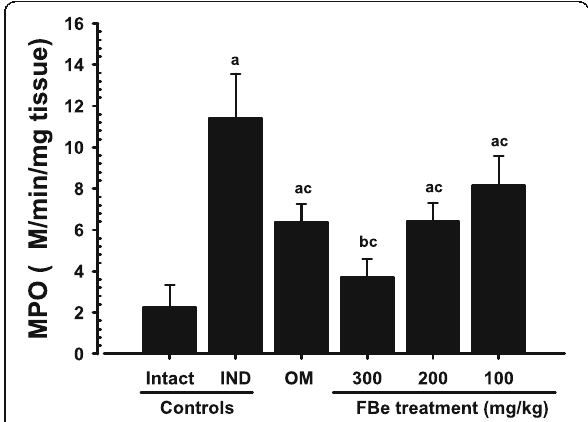
Fig. 4 Gastric MPO contents in the intact or IND-treated rats. Values are expressed as mean ± S.D. of eight rats, μ M/min/mg tissue. FBe: triple fermented barley extract as test material; IND: indomethacin; OM: omeprazole; MPO: myeloperoxidase. All test substances were single orally administered, at 30 min before IND 25 mg kg − 1 single oral treatment, and all animals were sacrificed at 6 h after IND treatment. a p < 0.01 and b p < 0.05 as compared with intact control by MW test. c p < 0.01 as compared with IND control by MW